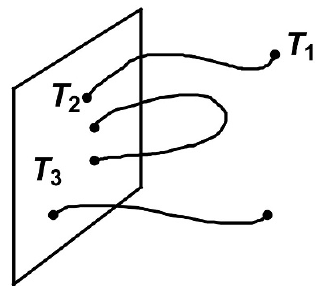
Figure 9 . The di(cid:11)erent tensions in the system, T 1 is the tension of the string, T 2 is the tension between the string and the worldsheet and T 3 is the brane tension